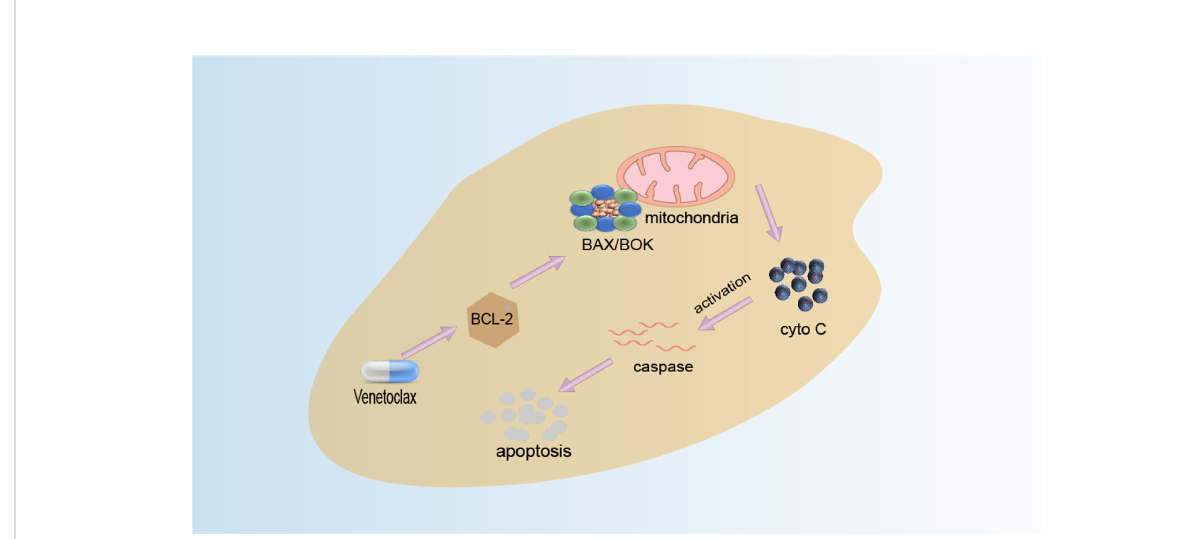
FIGURE 4 Venetoclax mechanism diagram. Venetoclax is a highly selective inhibitor of BCL-2. Highly expressed cancer cells of BCL-2 are spared from apoptosis by inhibiting the activation of BAX and BAK. Venetoclax selectively binds to BCL-2 in the binding tank, directly and indirectly reducing the inhibitory effect on BAX/BAK and initiating